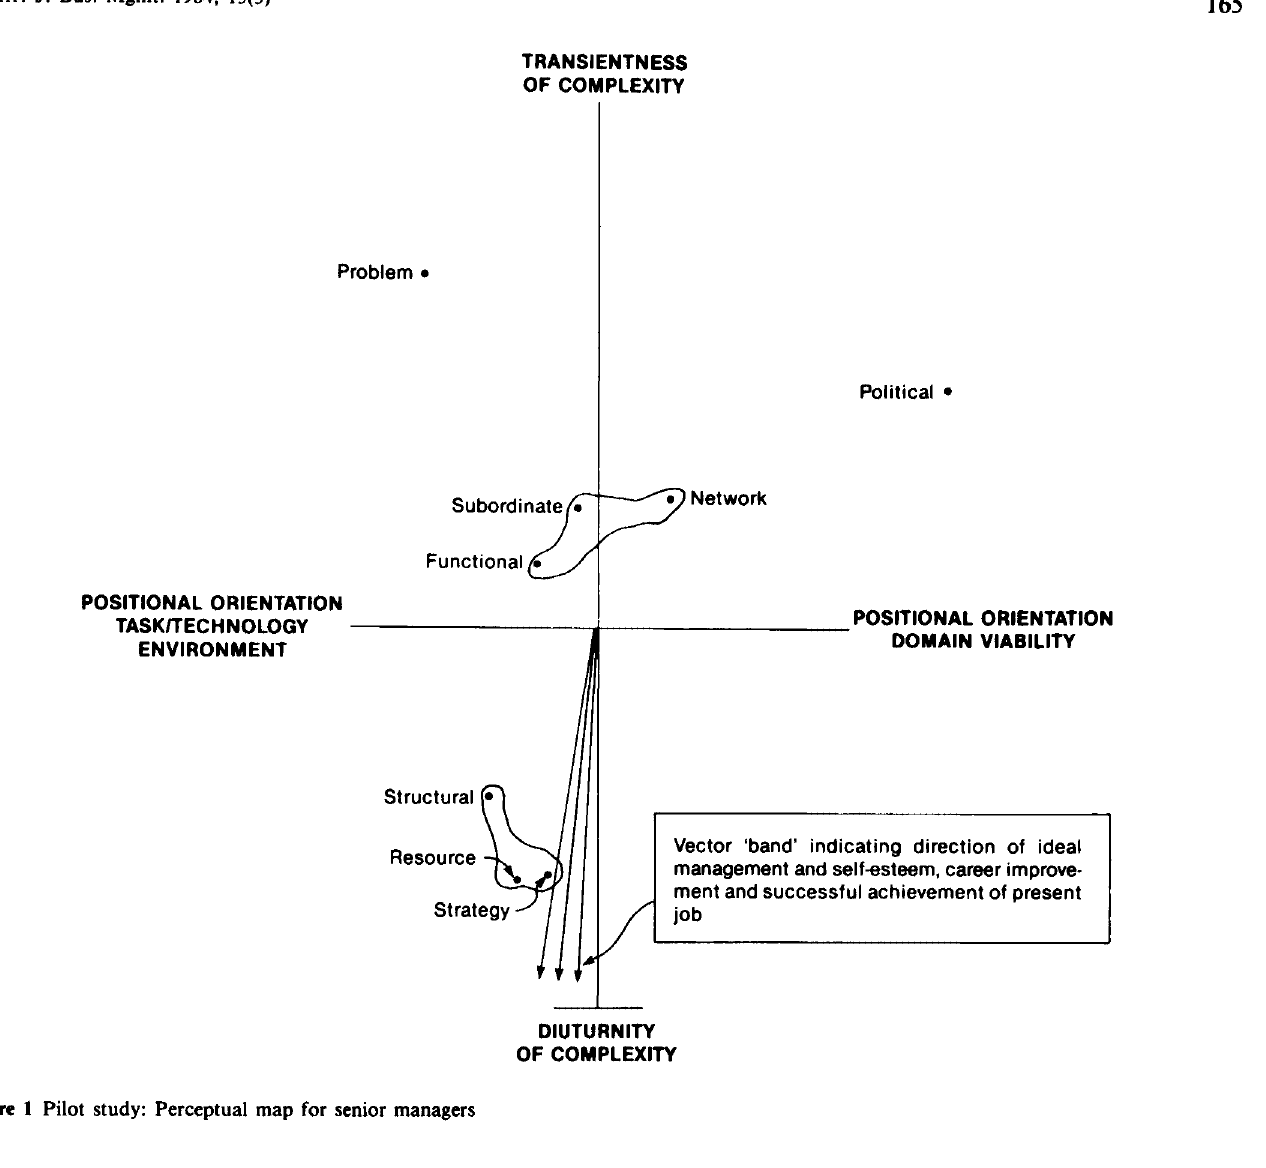
Figure 1 Pilot study: Perceptual map for senior managers